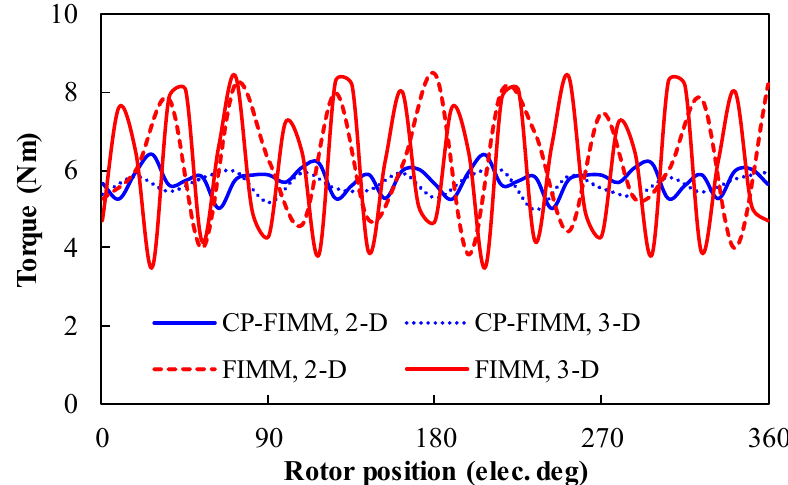
Figure 19. Three-dimensional models of the two machines. ( a ) FIMM. ( b ) CP-FIMM.